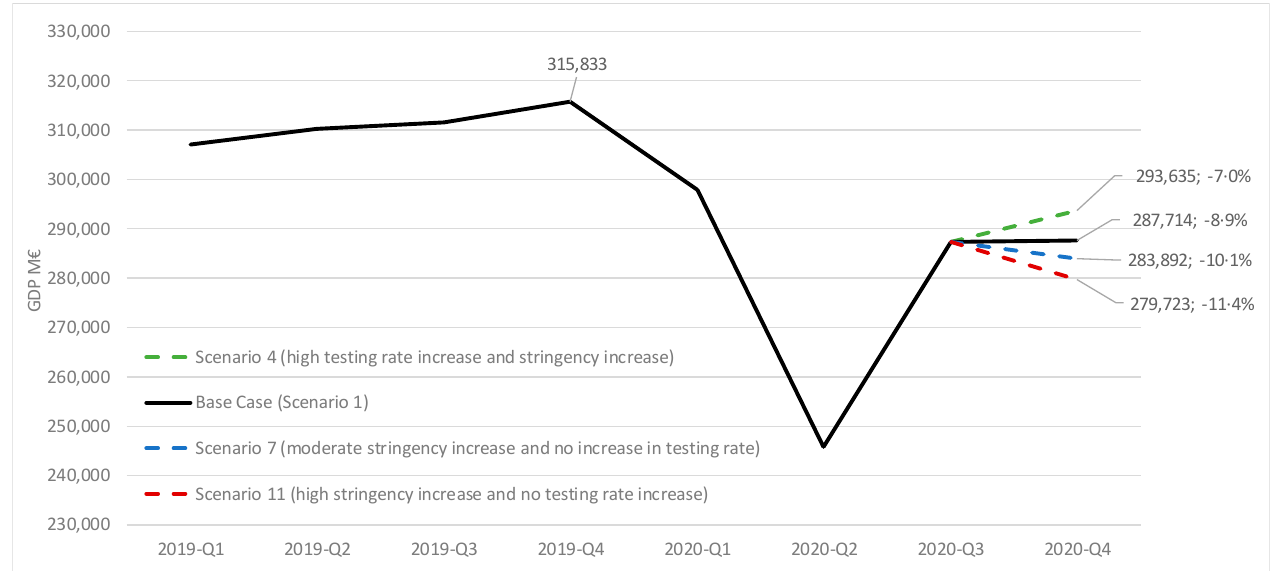
Figure 6. Potential Q4 GDP 2020 evolution for different scenarios of testing and stringency. GDP in million €; % change vs. GDP from Q4 2019. M€: million €.